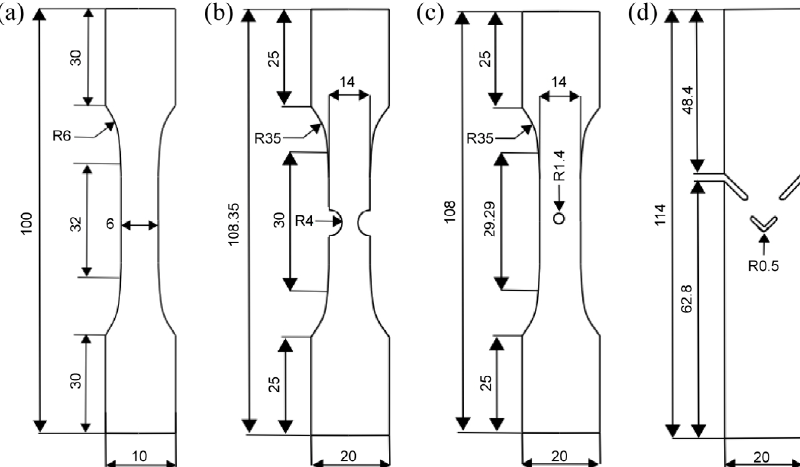
Fig. 3 Schematic of specimen geometries for (a) UT, (b) NT, (c) CH, and (d) SH specimens (all dimensions are in mm).